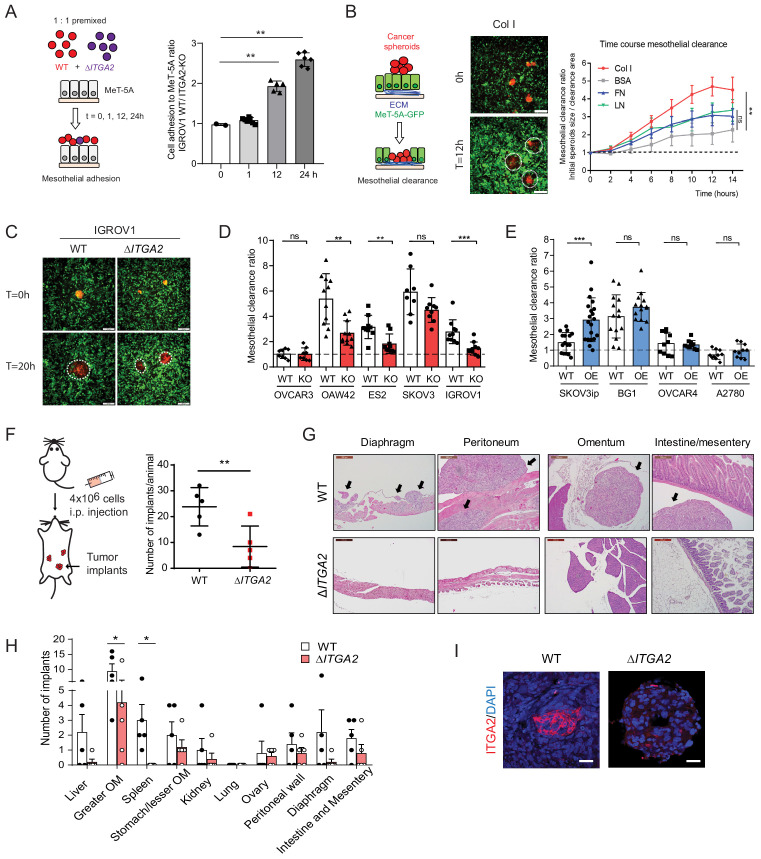
ITGA2 promotes mesothelial clearance and metastasis to the omentum in vivo.(A) Cancer cell-mesothelial adhesion assay was performed by seeding equal numbers of fluorophore-labeled WT and ΔITGA2 single cancer cells on a confluent monolayer of MeT-5A cells. Bar chart shows the adhesion ratio of WT vs ΔITGA2 to MeT-5A cells at different time points. (B) Stable RFP-expressing cancer cell spheroids were seeded on top of a GFP-expressing MeT-5A mesothelial monolayer pre-coated with different ECM substrates. Mesothelial clearance activity was measured over time by time-lapse microscopy. Clearance ratio >1 suggests active enhanced clearance activity. Scale bar 200 μm. Line chart summarizes mesothelial clearance activity on different ECM substrates over time. (C) Representative images of mesothelial clearance assay of SKOV3 WT and ΔITGA2 cancer cell line at time point 0 and 20 hr. Scale bar 200 μm. (D) Bar chart shows mesothelial clearance ratio for WT versus ΔITGA2 (n = 5) and (E) WT versus ITGA2-overexpressed (OE) (n = 4) EOC cell lines with mean ± SD (unpaired Student’s t-test, ***p<0.001), each dot represents single spheroid clearance activity. (F) Dot plot shows the total number of tumor implants per animal after 8 weeks intraperitoneal injection of 4 × 106 SKOV3 WT and ΔITGA2 cells in NIH(S)II: nu/nu mice. (G) Representative H and E staining of the xenografts and metastases. Black arrows indicate the tumor metastases. Scale bar 200 μm. (H) Bar chart summarized the number of tumor foci in different organs. Mean ± SD (One-way Anova, *p<0.05). (I) Representative immunofluorescence staining of ITGA2 expression in the omental tumor xenograft.